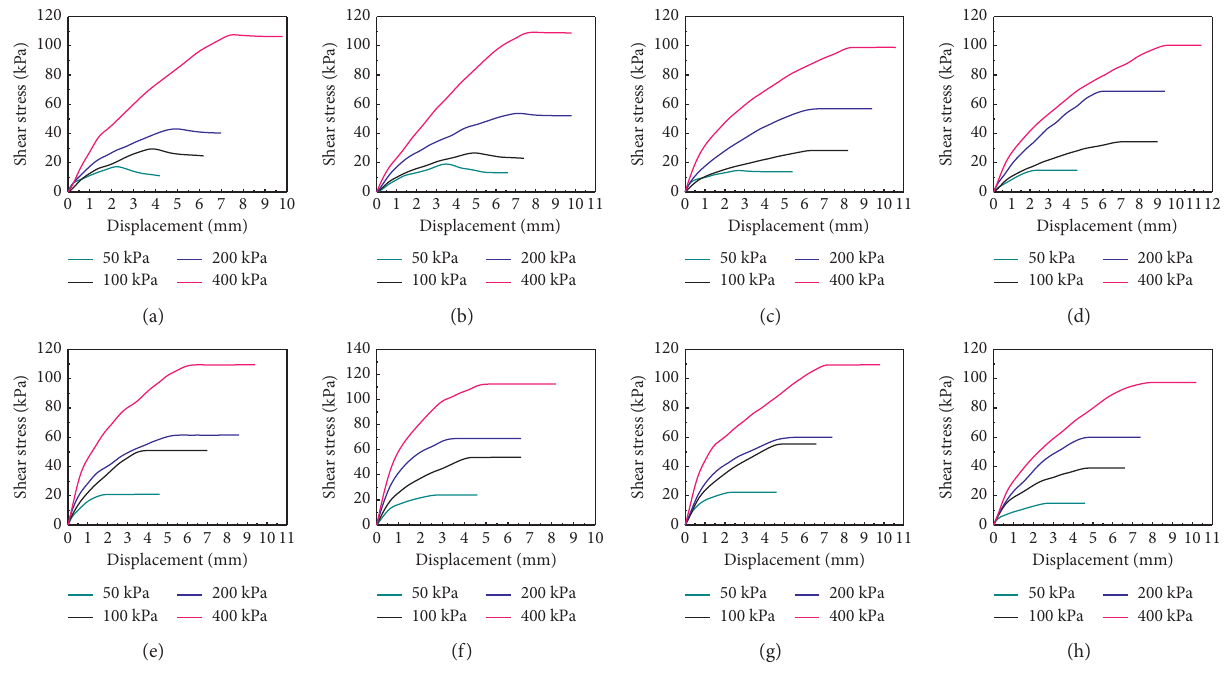
Figure 7: Shear stress-displacement curve of extremely soft coal: (a) w � 0 . 966%; (b) w � 3 . 841%; (c) w � 7 . 688%; (d) w � 12 . 957%; (e) w � 17 . 888%; (f) w � 20 . 847%; (g) w � 22 . 072%; (h) w � 24 .